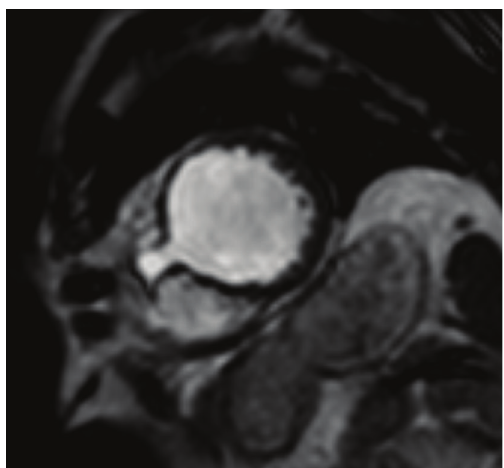
Figure 1: Four-chamber CE-MRI revealed an extensive transmural anterior AMI with septal involvement. Figure 2: Short axis MRI shows the hemodynamically significant